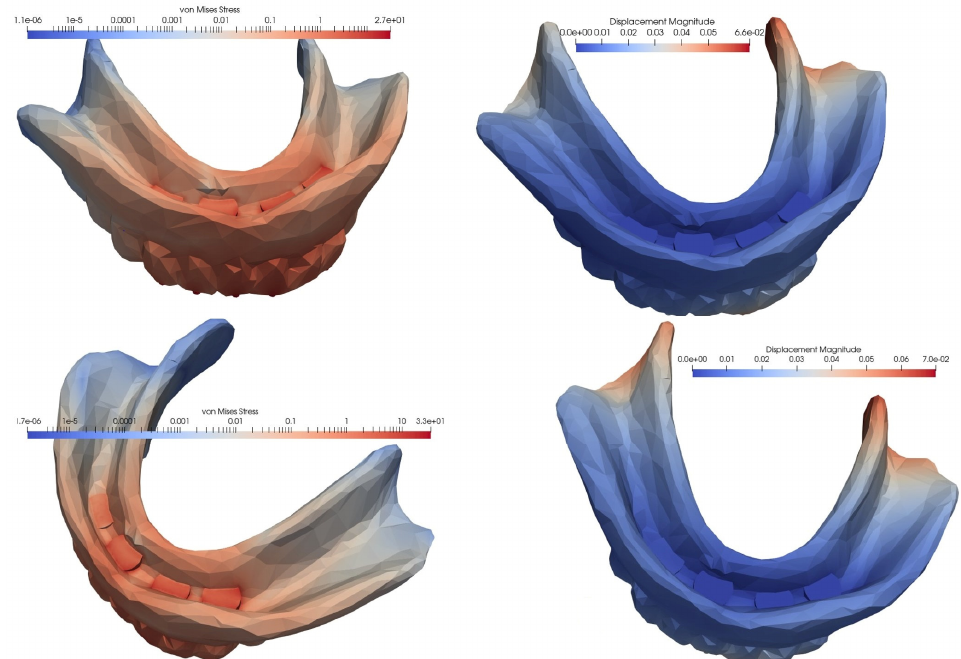
Figure 5. The von Mises stresses and displacements generated by the frontal loading of an overdenture on four interforaminally inserted MDIs ( top ), compared to the loss of a distal implant ( bottom ).